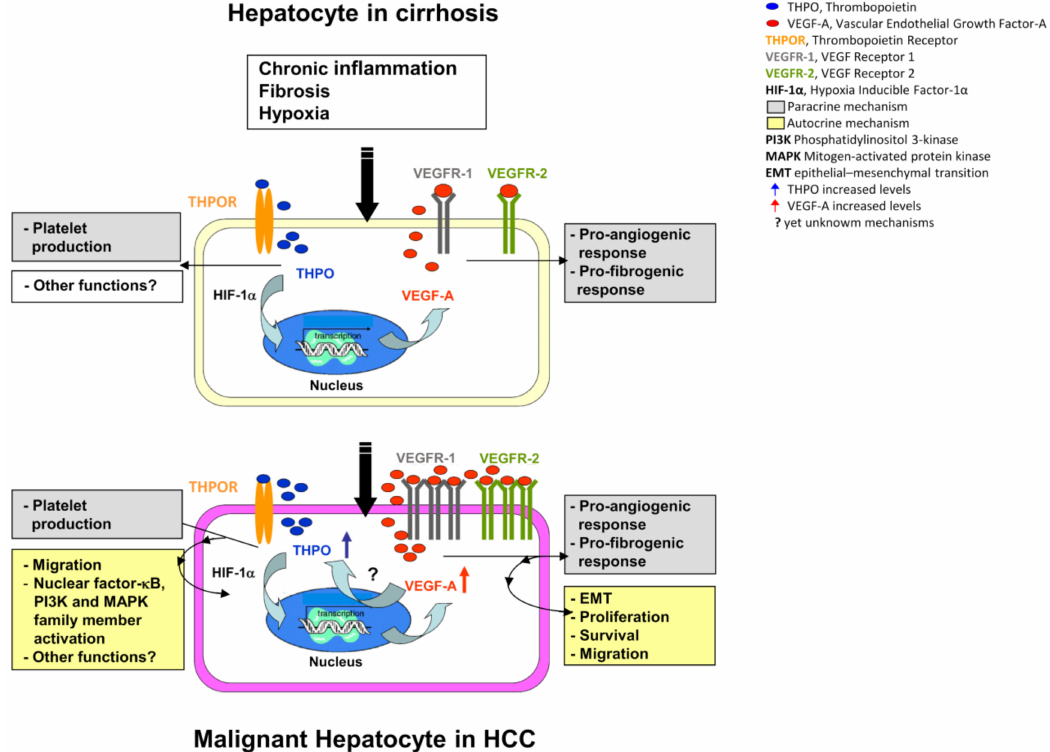
Figure 10. Hypothetical role of THPO in the transition from liver cirrhosis to HCC. In HCC, THPO binds hepatocytes c-Mpl, activates HIF-1 α , and stimulates the production of VEGF-A. VEGF-A acts in an internal autocrine fashion, and by a still-unknown mechanism, induces the production of THPO, creating an insidious positive mutual loop that provides signals for progression from preneoplastic liver lesions to